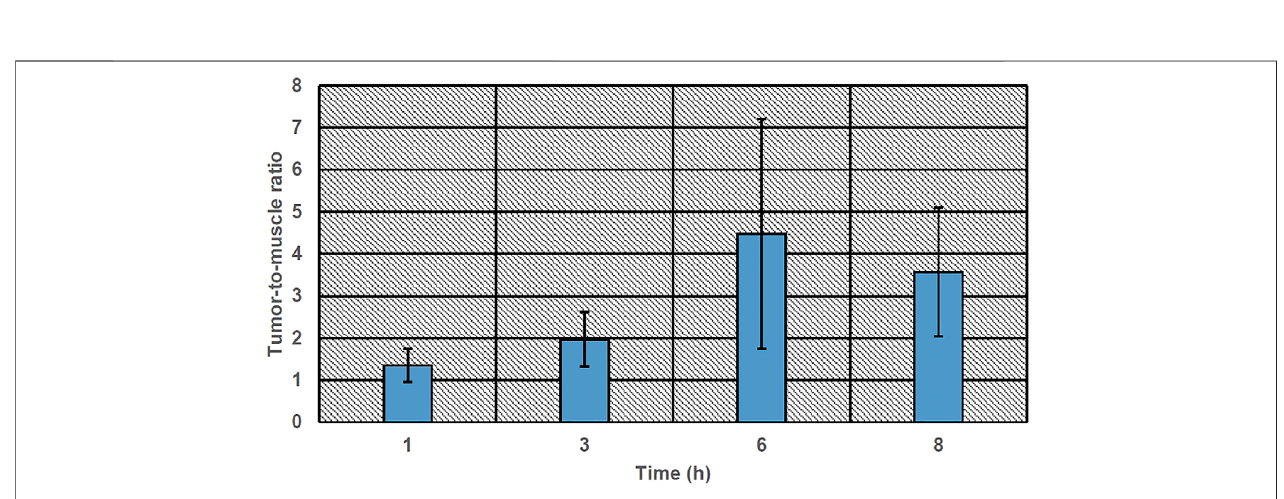
FIGURE 6 | Tumor-to-muscle ratio of 99mTc-labeled niosomes.